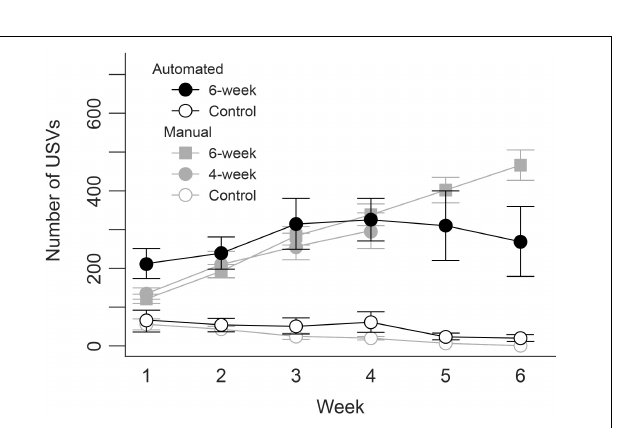
FIGURE 6 | Representative results of the weekly increase in ultrasonic vocalization production during semi-automated training compared to previous manual